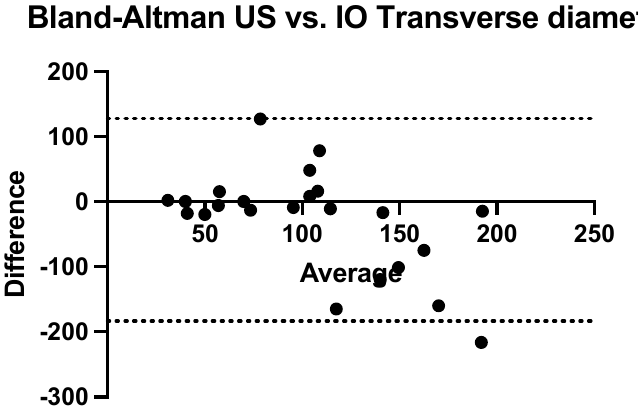
Figure 6. Bland-Altman analysis comparing anteroposterior diameter measured using computed tomography versus intraoperative measurement (TC = computed tomography, IO = intraopera- tively). Bland-Altman US vs. IO Transverse diameter